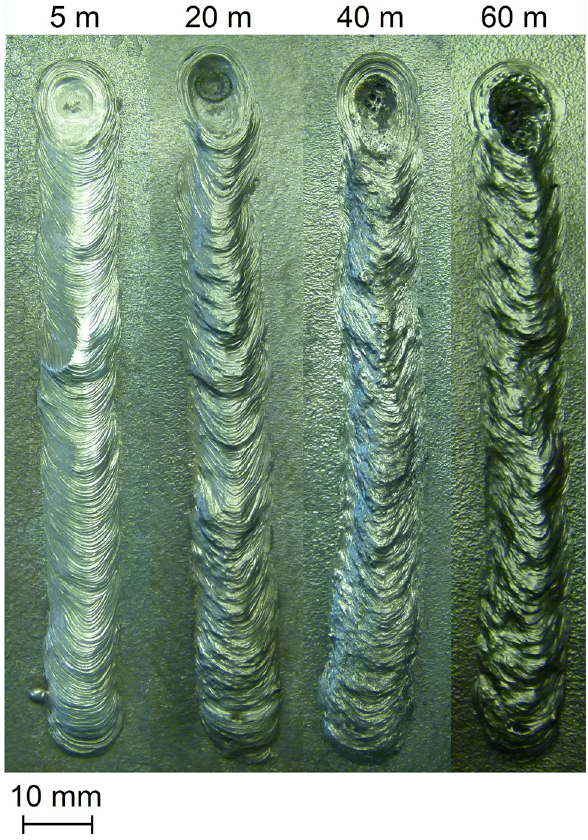
Fig. 10 Bead on plate weld seams welded with the stick electrode HK3 in the water depth 5 m, 20 m, 40 m, and 60 m. The parameters used are listed in Table